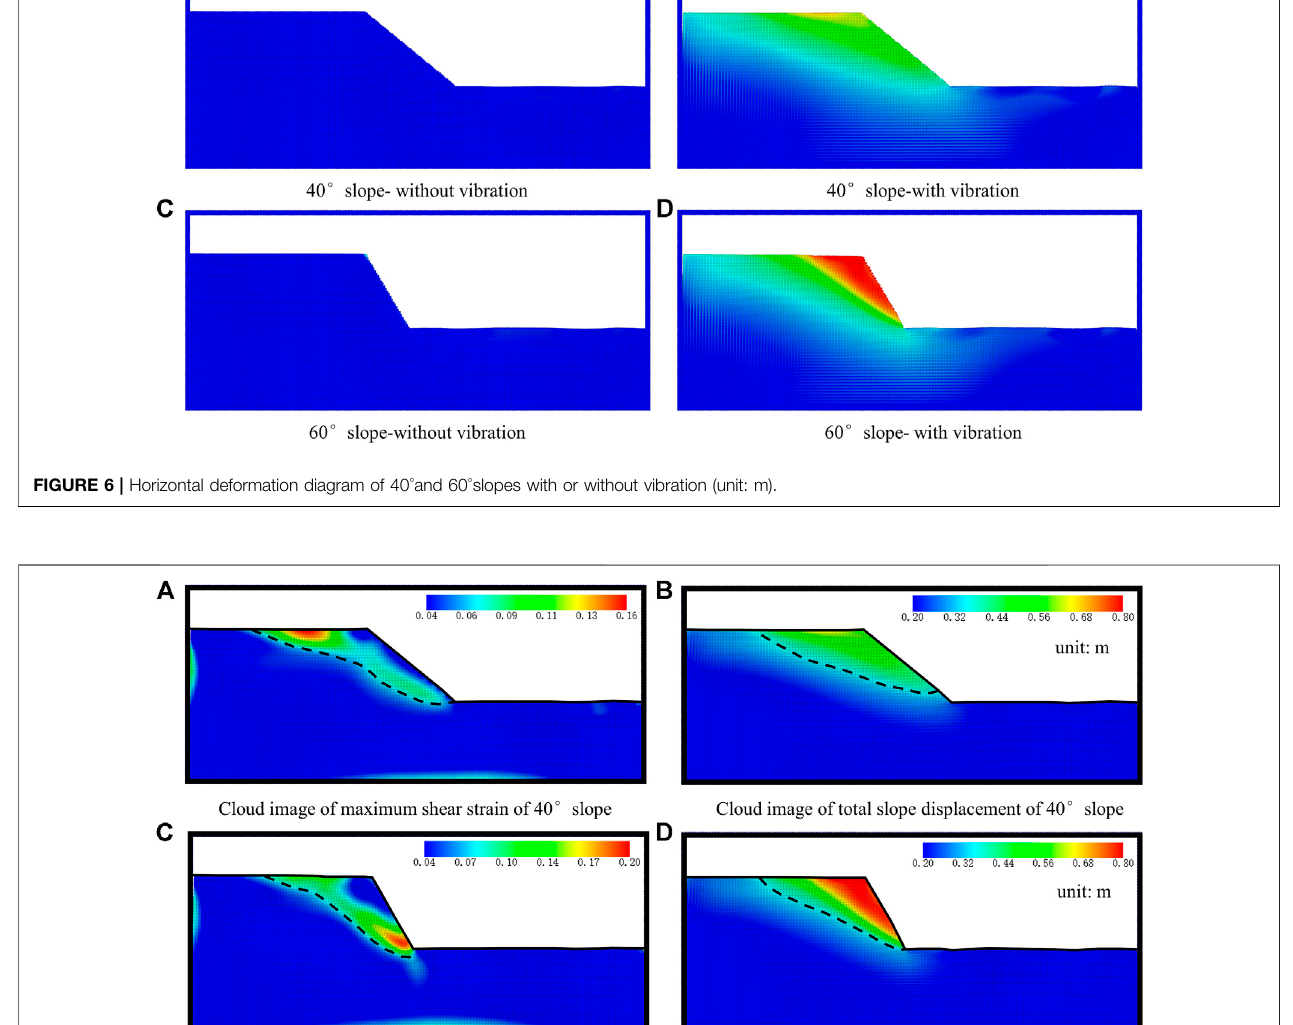
Frontiers in Physics |